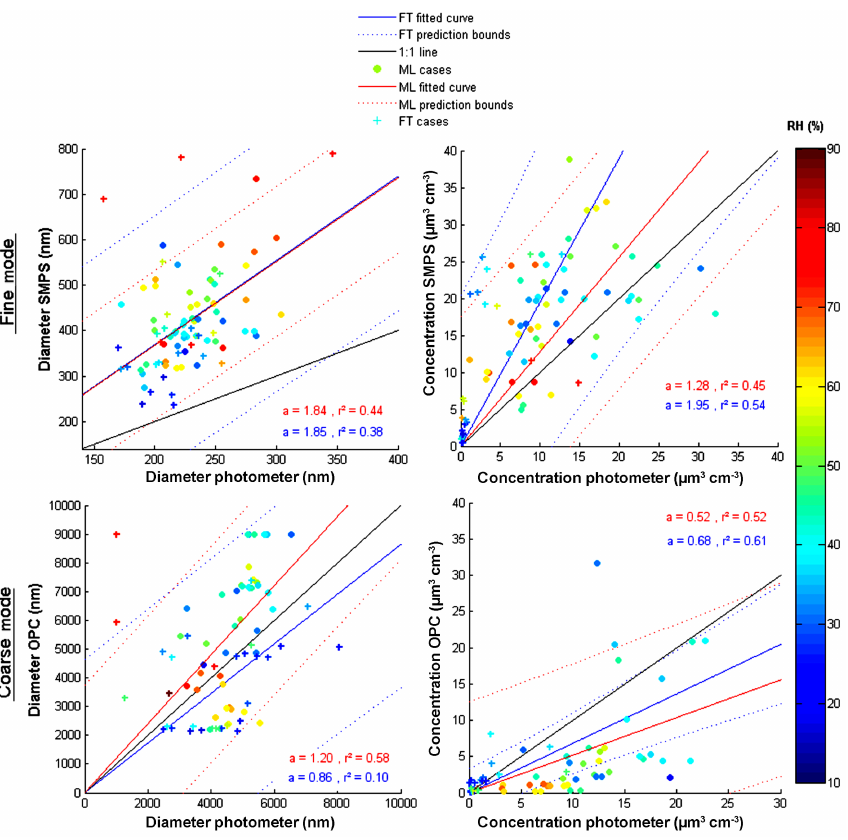
Figure 8. Scatter plot of fine and coarse mode modal diameters, and volume concentrations after applying the humidity growth factor (HGF). Colour corresponds to the mean relative humidity between the two stations. Blue fit and cross markers are for FT data and red fit and circle markers for ML